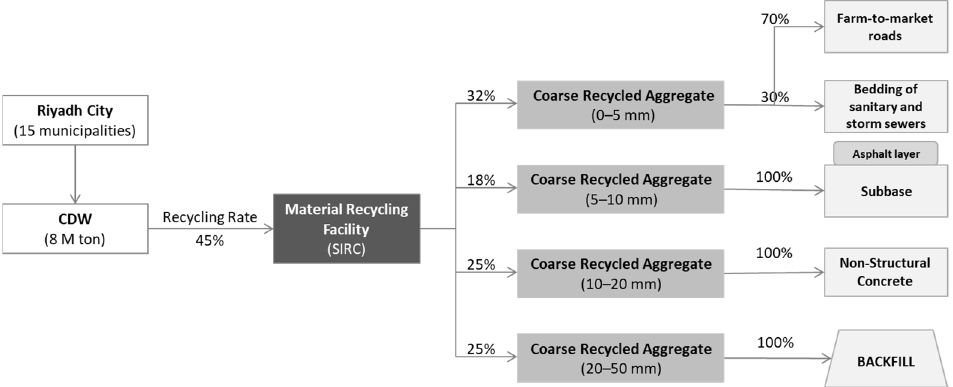
Figure 3. Overview of recycling process in Riyadh BCS.